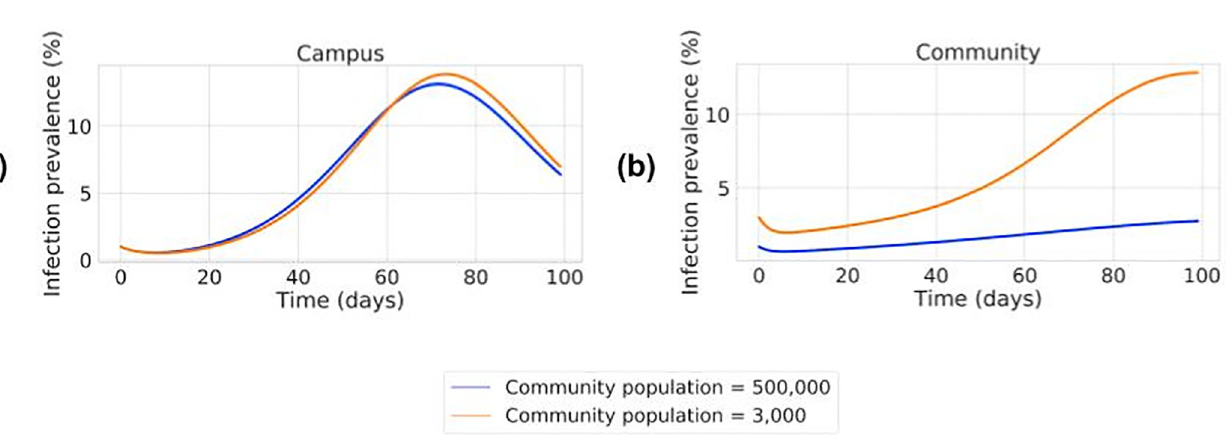
PLOS ONE | https://doi.org/10.1371/journal.pone.0254798 August 12,